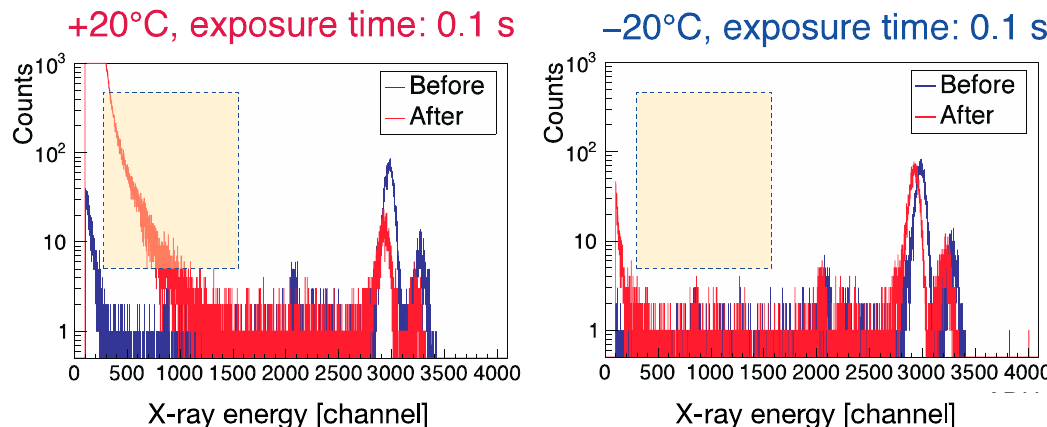
Figure 9. Comparison of the Mn-K α and K β spectra obtained before and after the 100 MeV proton irradiation. Although the noise tail appears on the low-energy side at +20 °C, after cooling of sample to − 20 °C, contribution of dark noise is significantly reduced. (Reprint Figure 10 in p.5 of N. Ogino et al . , Nucl. Inst. and Methods in Phys. Research, A987(2021) 164843) .